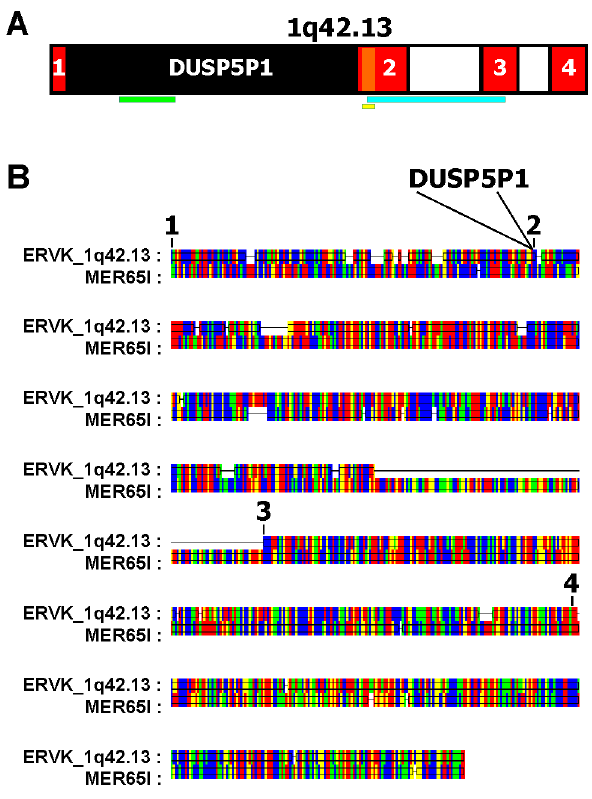
Figure 2. Schematic presentation of human chromosome 1 band 1q42.13 and the DUSP5P1 locus. (A) The sequence of the vector shown in Figure 1 is indicated by an orange rectangle. This sequence is part of a larger ERV sequence (colored red) on chromosome 1 at band 1q42.13 which was identified as described in Material and Methods. This larger sequence is split into several parts. Only the 4 parts with highest homology to an ERV in chromosome 4 are shown. Part one and two of this ERV are separated by a pseudogene of DUSP5 (DUSP5P1). Locations of PCR Products with primers with specificity for DUSP5P1 (green), the cloned cDNA (ERVK_1q42.13_library; yellow) and the ERV segments 2 and 3 (ERVK_1q42.13; blue) are indicated by horizontal bars. (B) Sequence alignment of the newly identified ERV and an ERV from chromosome 4 (MER65I, RetroSearch ERV-ID: 16168). The position of the DUSP5P1 insertion in ERVK_1q42.13 is indicated. Color code: red: A; green: C; yellow: G; blue: T. Data visualization was performed with GeneDoc